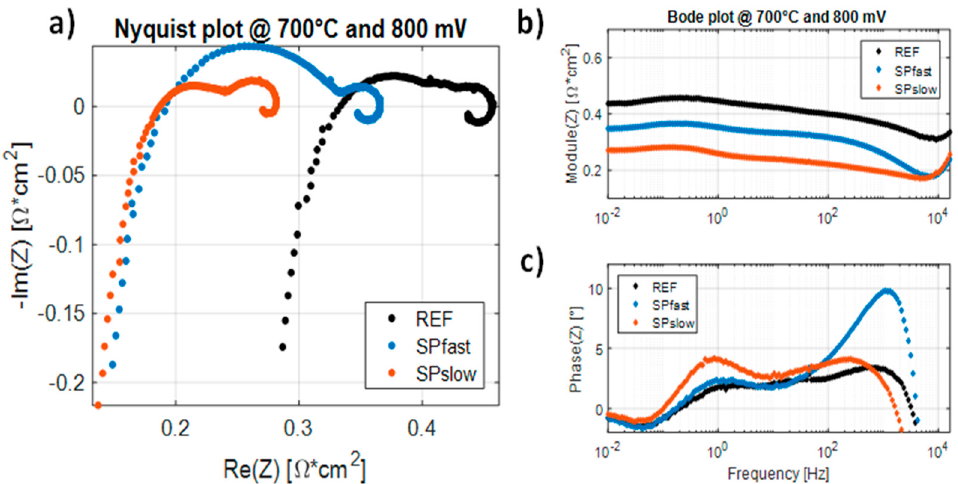
Figure 10. Nyquist ( a ) and Bode ( b , c ) plots of samples REF (black markers), SPfast (blue markers), and SPslow (red markers) measured at 700 °C and 800 mV.